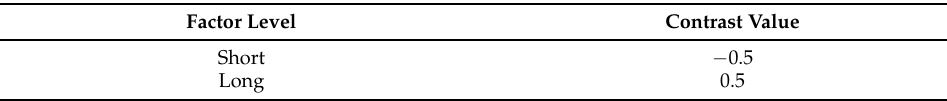
Table A13. Contrasts for Experiment 1 Length